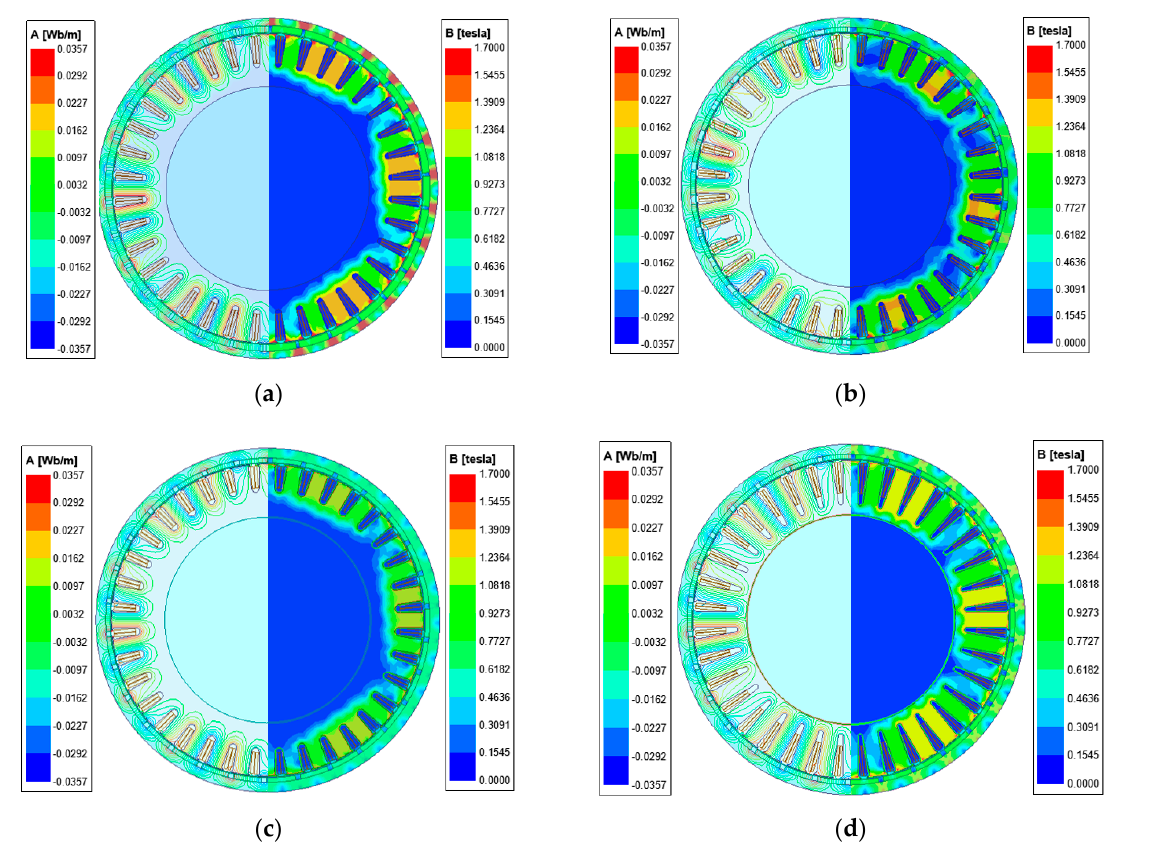
Figure 14. Magnetic flux density distributions under four schemes: ( a ) Case 1; ( b ) Case 2; ( c ) Case 3; ( d ) Case 4. After 2D-FEA simulation using Ansys Maxwell software, the stator core loss, rotor core loss, eddy current loss of the PM, and copper loss under rated load are obtained, as